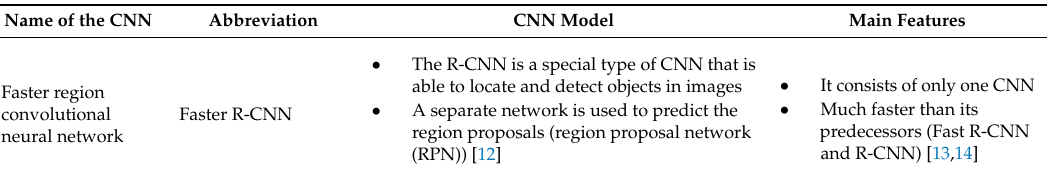
Table 1. Description of selected convolution neural networks (CNNs).